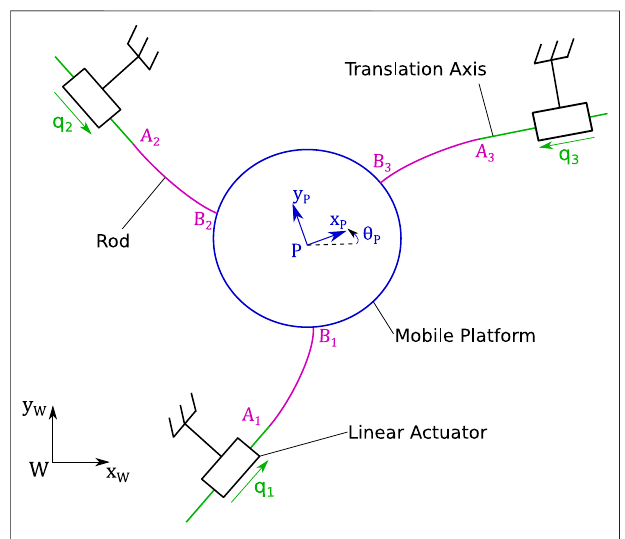
FIGURE 2 | Kinematic diagram of the 3-PF planar Parallel Continuum